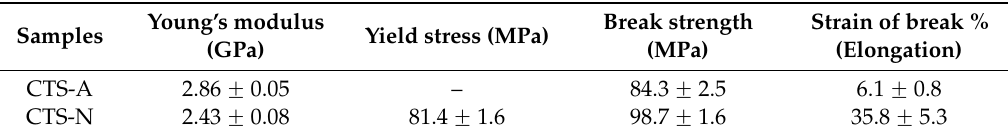
Figure 1. ( a ) XRD patterns of CTS-A and CTS-N at room temperature; and ( b ) stress–strain curves of CTS-A and CTS-N. Table 1. Tensile properties of CTS-A and CTS-N samples.